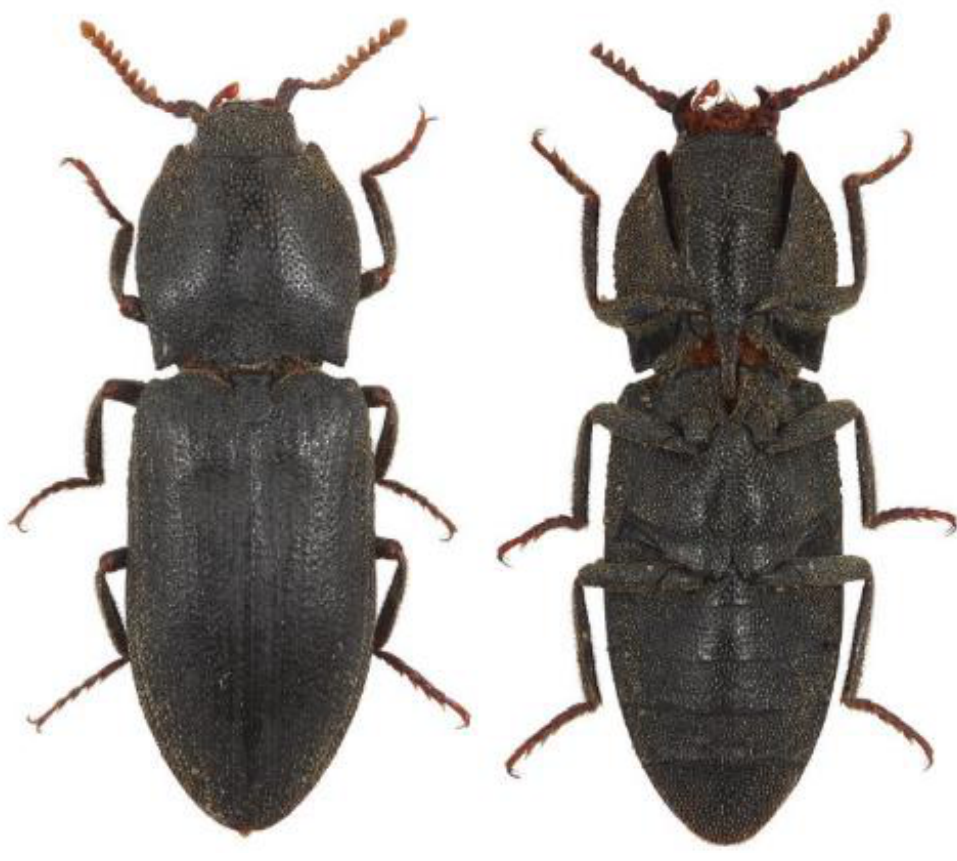
Рис. 1. Общий вид (сверху и снизу) Compsolacon crenicollis из Краснодарского края (фотография С.О. Какунина,